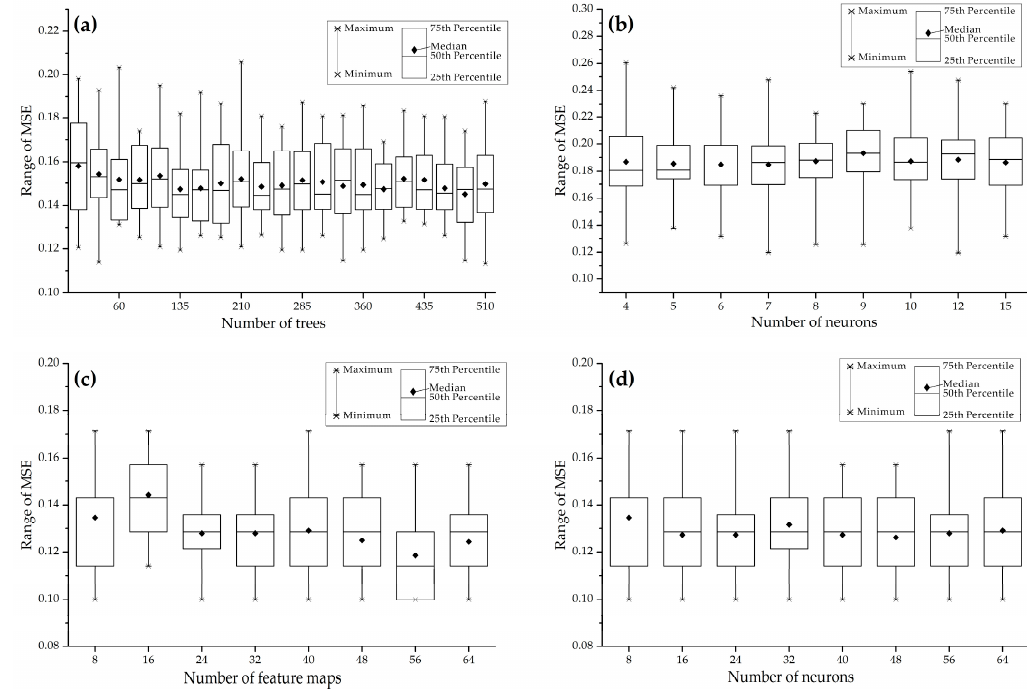
Figure 9. Box plot showing the statistical results of MSE against the variations of parameters related to model complexity: ( a ) number of trees employed in RF; ( b ) number of neurons employed in ANN; ( c ) number of feature maps employed in CNN; and ( d ) number of neurons employed in CNN.